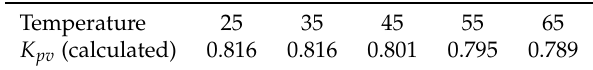
Table 7. The calculated voltage factor for different temperature values.